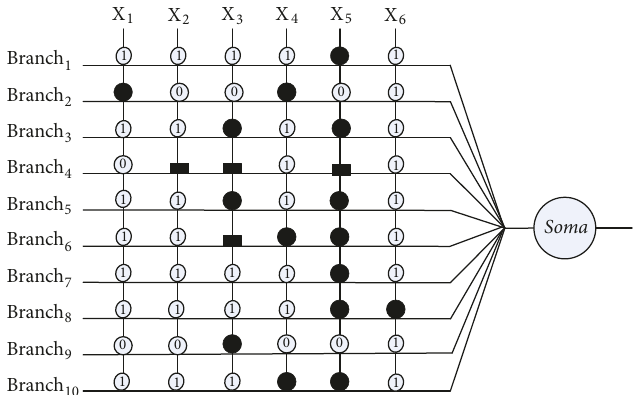
Figure 8: The dendritic morphology of the Qualitative Bankruptcy data set after learning.